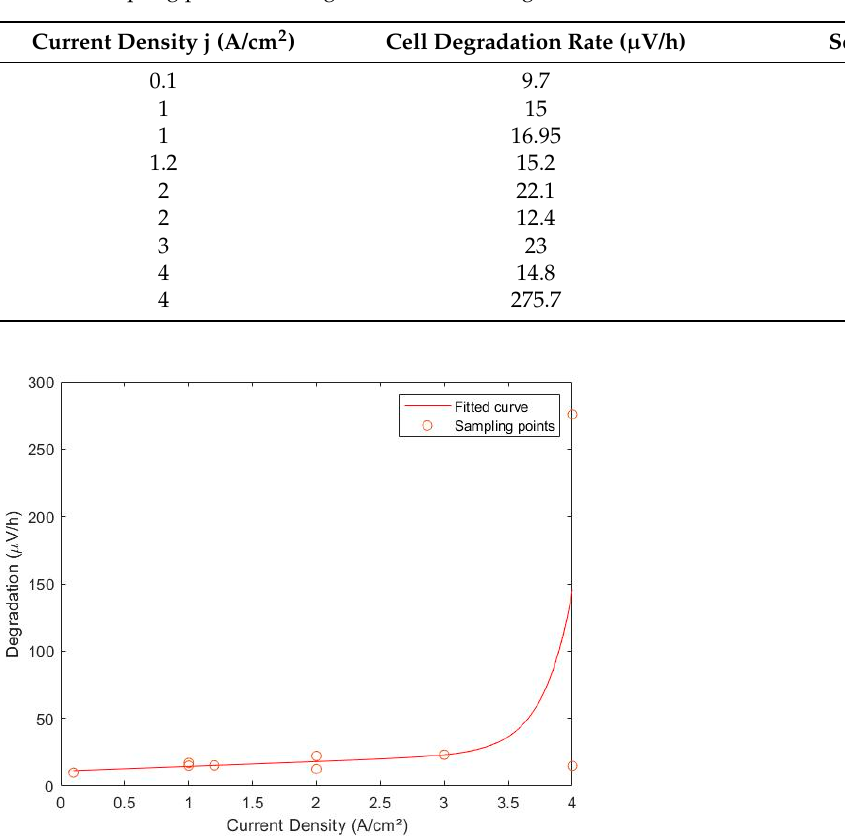
Table 2. Sampling points for the generation of the degradation curve for an ELY.